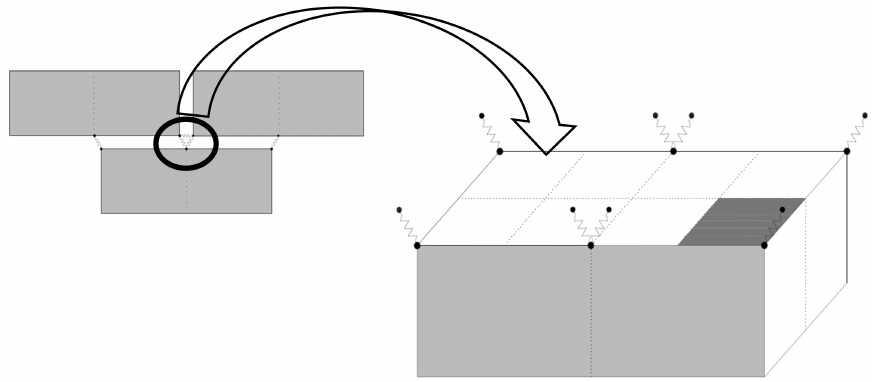
Figure 5. Tributary area on nodes for nonlinear